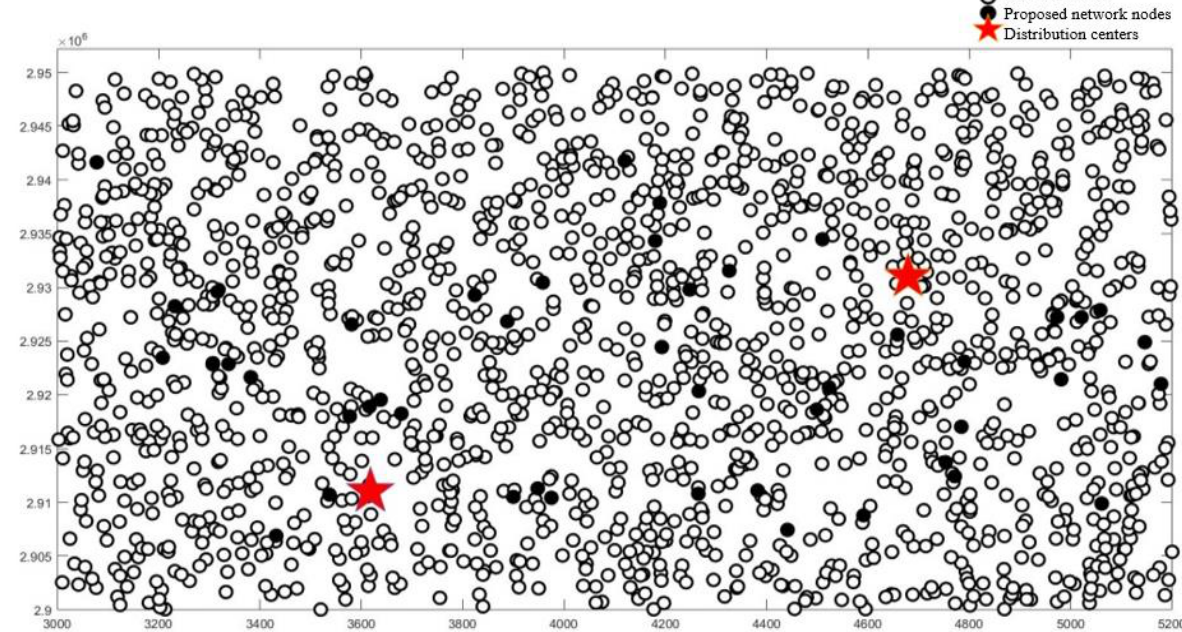
Figure 10. Schematic of the 2021 demand points and distribution centers.